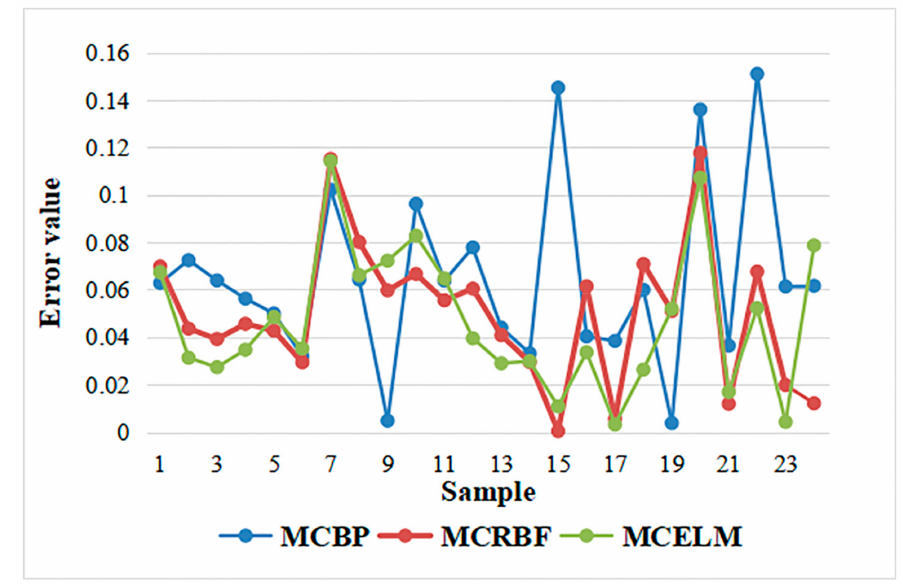
Figure 6. Prediction error comparison of MCBP, MCRBF, MCELM with 15 nodes. At this time, the prediction effect is poor with many errors exceeding 0.1. Adjust the number of hidden layer nodes of the neural network to 10. The errors of the MCBP, the MCRBF, and the MCELM are described in Figure